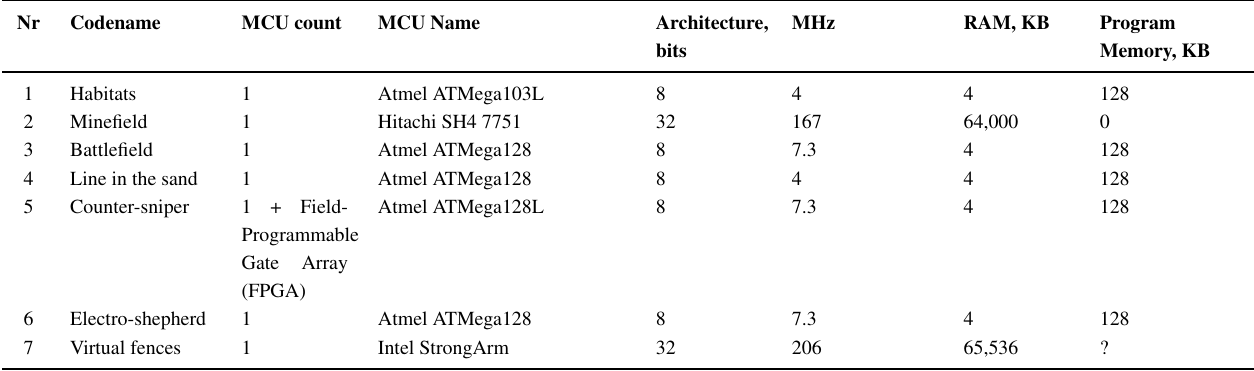
Table 6. Deployments: used microcontrollers